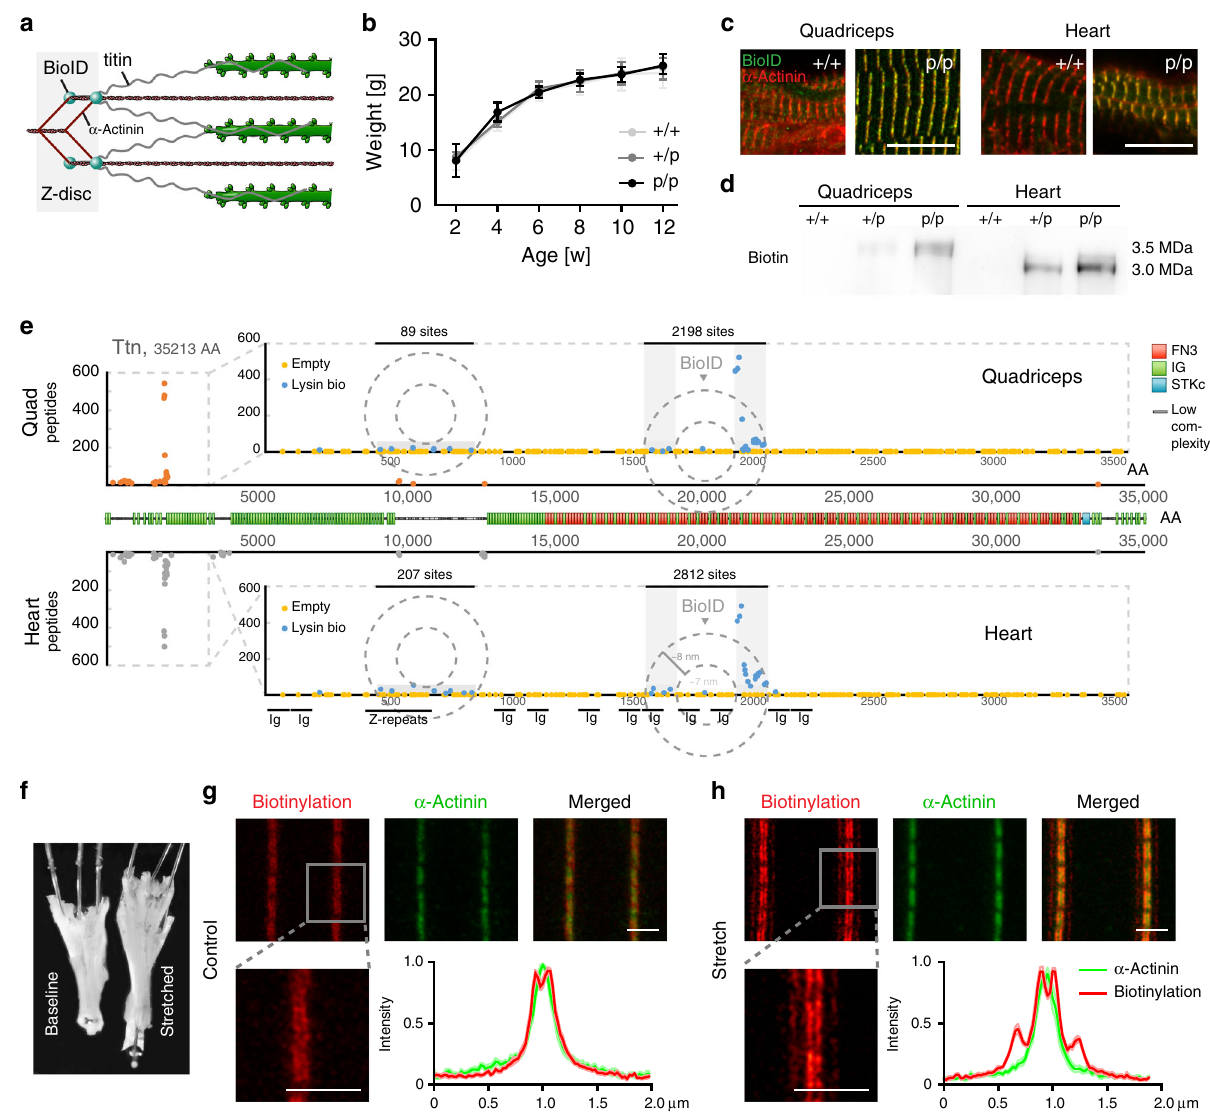
Fig. 1 Titin Ig8/9 dissociates from the Z-disc upon stretch. a Knock-in of BioID between Z-disc and I-band titin to probe the Z-disc proteome. b Body weight develops normally in TiZ-BioID knock-in- (p/p or p/ + ) and control mice ( + / + ). Mean ± SD, n = 23. Two-way ANOVA p < 0.0001 for time, not signi fi cant for genotype or interaction. c Z-disc colocalization of BioID (green) and α -actinin (red) at the Z-disc. Scale bar 10 µ m. d Ligand blot with streptavidin with biotinylated titin proteins at the expected sizes and increased signal in homo- vs. heterozygotes. e Biotinylation sites along the titin protein. Dashed boxes represent the magni fi ed extended Z-disc region with biotinylation hotspots around the BioID insertion site and the end of the Z-repeats (biotinylated lysin blue, unmodi fi ed lysins orange). Dashed circles indicate the range of BioID activity. f Flexor digitorum brevis muscle at resting length (baseline) or stretched by 10% and fi xed with minutien pins. g Stimulated Emission Depletion Microscopy (STED) of fl exor digitorum brevis muscle (FDB) without mechanical strain ( fi xed at slack length) from TiZ-BioID mice (streptavidin staining for biotinylated proteins, red; anti- α -actinin for Z-disc, green). Boxes indicate the area of quanti fi cation for the intensity plots of the biotinylation signal and α -actinin ( n = 9; mean ± SEM). h STED of FDB stretched by ~10%. A biotin hotspot is dislocated from the Z-disc upon stretch. Traces represent mean ± SEM, n = 9. Scale bar 1 µ m. Source data are provided as a Source Data fi